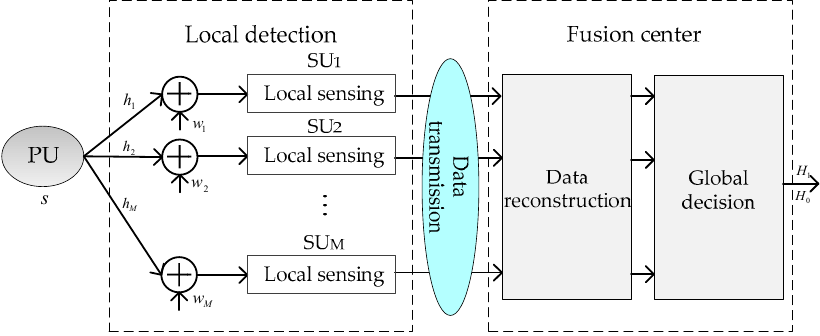
Figure 1. The structure of the cooperative spectrum sensing (CSS) system with the novel semi-soft decision rule.